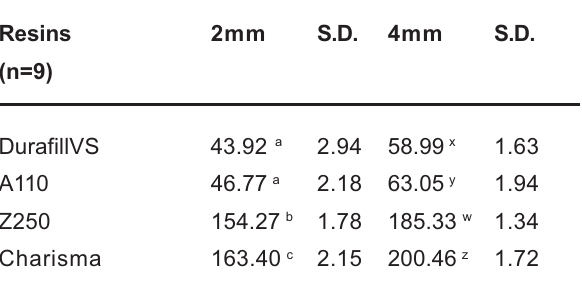
TABLE 2- Comparison among the optical density of the resins at the thicknesses of 2 mm and 4 mm